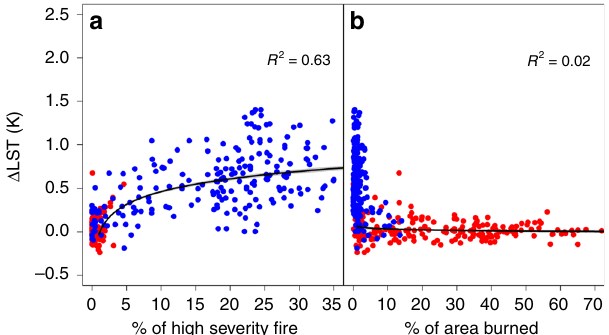
Fig. 5 Effects of fi re severity and burned area on summer (June, July, August; JJA) temperature. Panels show the relationship between land surface temperature change and a the percentage of high severity fi re, and b the percentage of burned area. Blue points show results from boreal forests, whereas red points show results from the tropical savannas within each 2 × 2 degree